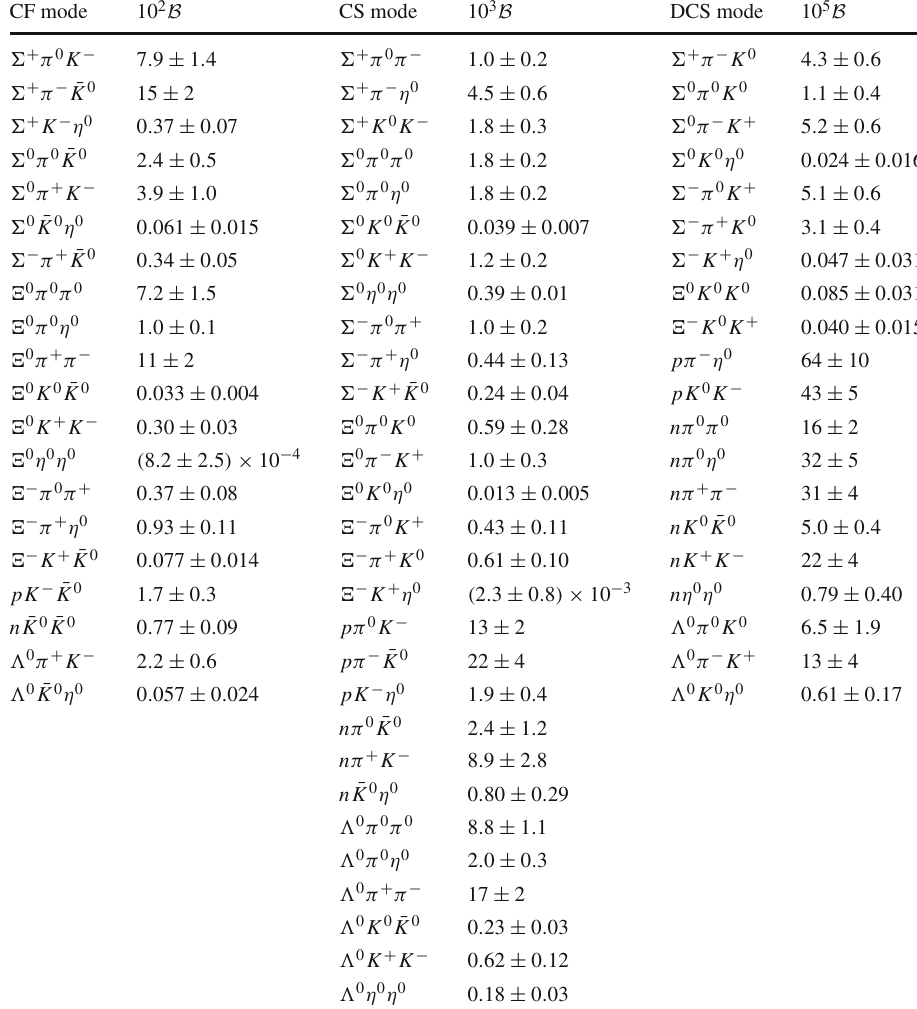
Table 8 Numerical results for (cid:3) → B B ((cid:2) 0 n MM c